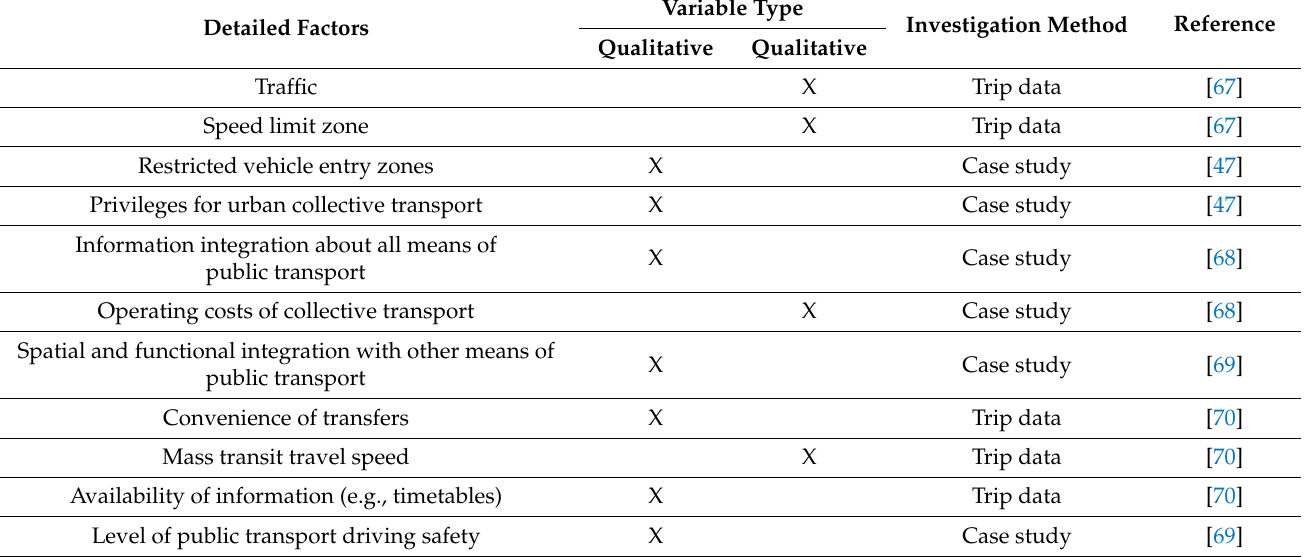
Table 8. Factors related to organizational